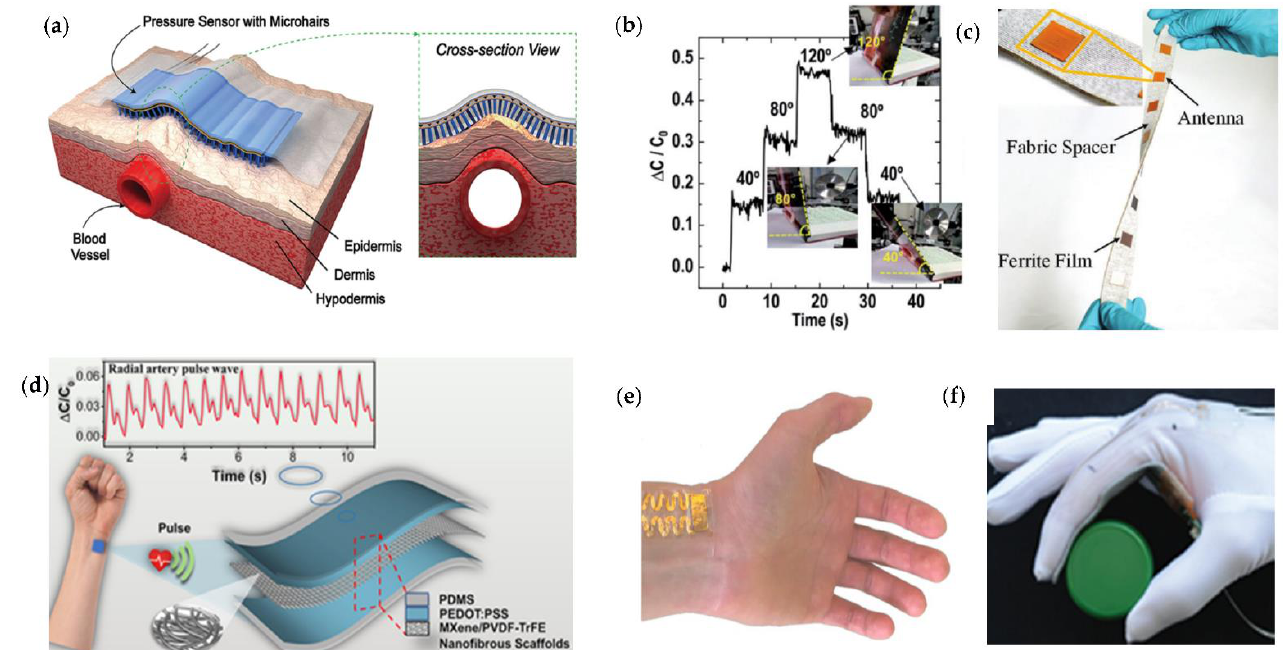
Figure 6. Some representative capacitive pressure sensors and applications. ( a ) Pulse-detectable pressure sensor with microhair structure (Reprinted with permission from ref. [95]. Copyright 2014 WILEY-VCH Verlag GmbH & Co. KGaA, Weinheim); ( b ) Capacitance response plot obtained from the wrinkled pressure sensor (Reprinted with permission from ref. [70]. Copyright 2017 Royal Society of Chemistry); ( c ) Textile-based flexible wireless pressure sensor(Reprinted with